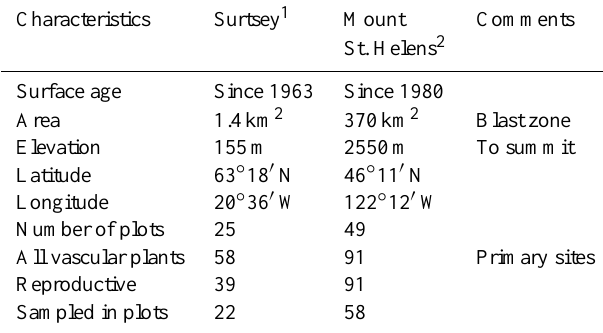
Table 1. General features of Surtsey and Mount St.